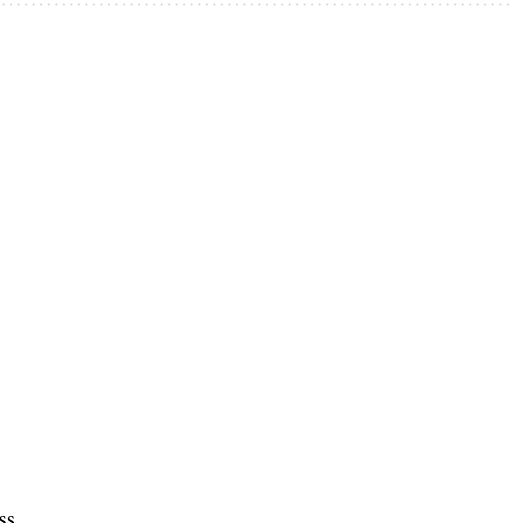
Figure 7. Estimated weights for control policies using different approaches. High positive values correspond to effective policies. Since in independent models each country has its own parameter set, for demonstrative purposes values for Poland are